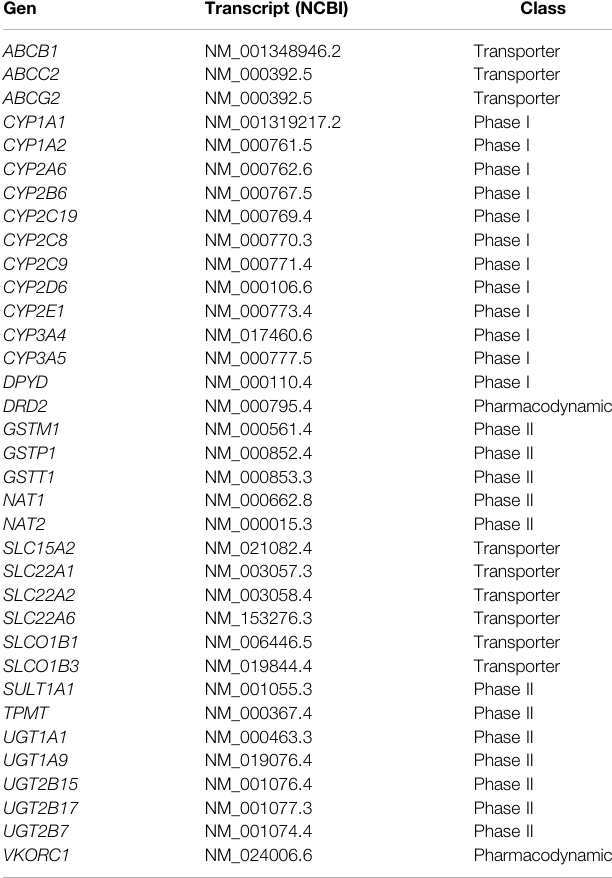
TABLE 1 | ADME core gene